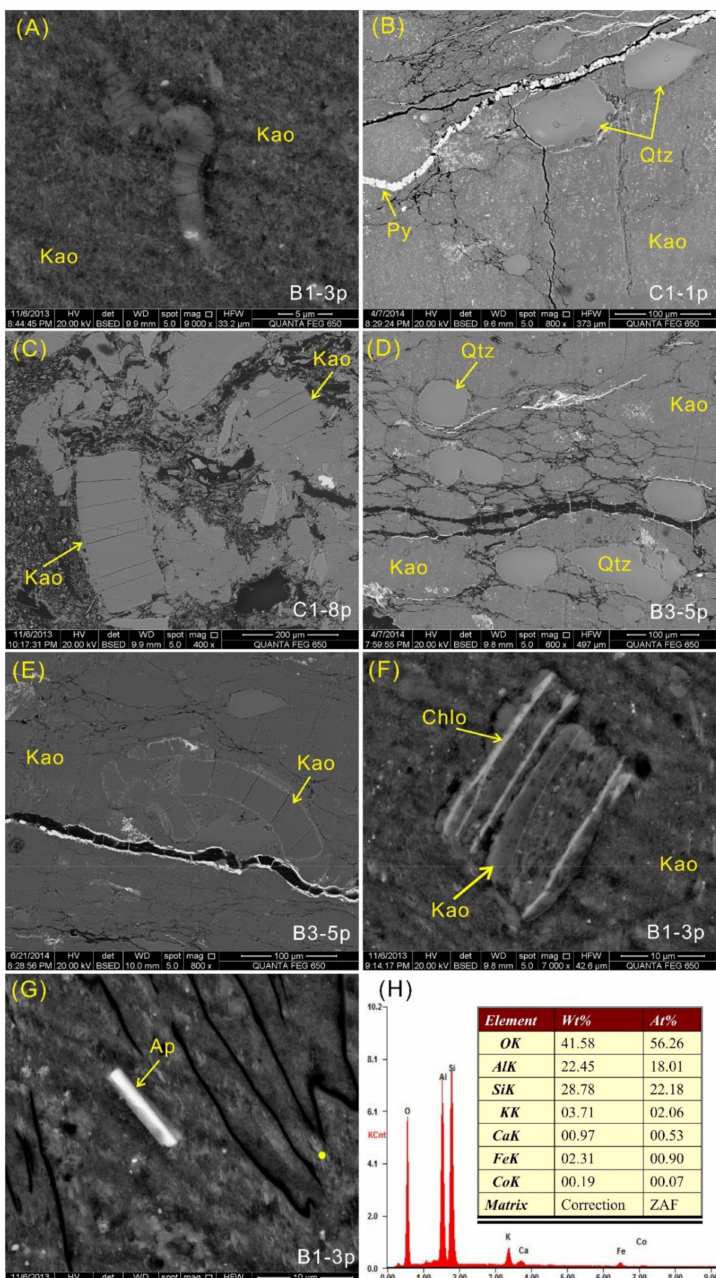
Figure 11. SEM back-scattered electron images of clay minerals in tonsteins and EDS data of selected point. ( A ) Vermicular kaolinite in sample B1-3p. ( B ) Cryptocrystalline kaolinite with quartz and pyrite in sample C1-1t. ( C ) Tabular kaolinite in sample C1-8p, possibly a pseudomorph after biotite or muscovite. ( D ) Elongated pellets and quartz in sample B3-5p. ( E ) Graupen and vermicular kaolinite in sample B3-5p. ( F ) Chlorite intergrown with kaolinite in sample B1-3p. ( G ) Mixed layer I/S and apatite in sample B1-3p. ( H ) EDS spectrum of point in ( G ). Kao: kaolinite. Qtz: quartz. Py: pyrite. Ap: